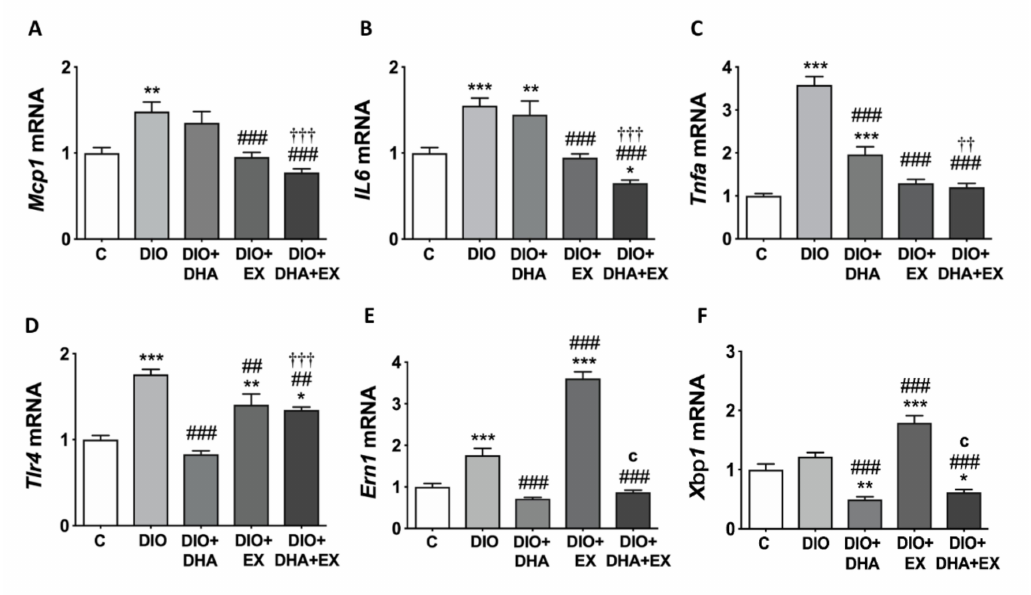
Figure 3. Long-term DHA supplementation and/or aerobic exercise training modulates the expression of pro-inflammatory genes ( A – D ) and of ER stress-related IRE1 α -XBP1 pathway genes ( E , F ) in the liver of 18-month-old DIO mice. Gene expression values were normalized to control group. Data are mean ± SEM. n = 6–10. * p < 0.05, ** p < 0.01, *** p < 0.001 vs. C group. ## p < 0.01, ### p < 0.001 vs. DIO group. †† p < 0.01, ††† p < 0.001 for DIO + DHA vs. DIO + DHA + EX group. c p < 0.001 for DIO + EX vs. DIO + DHA + EX